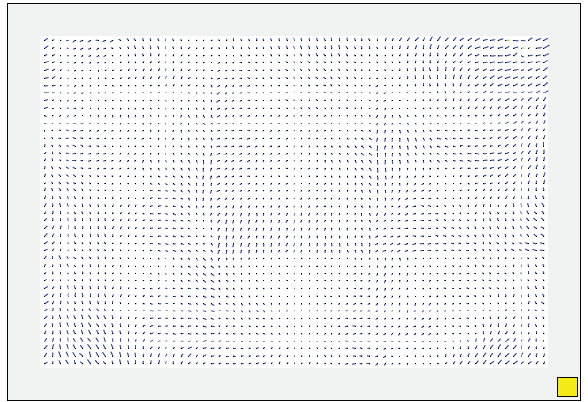
Figure 4. Residual images vectors for the used Eagle Mark 1 with average length of 0.163 pixels and maximum of 1.865 pixels (graph from